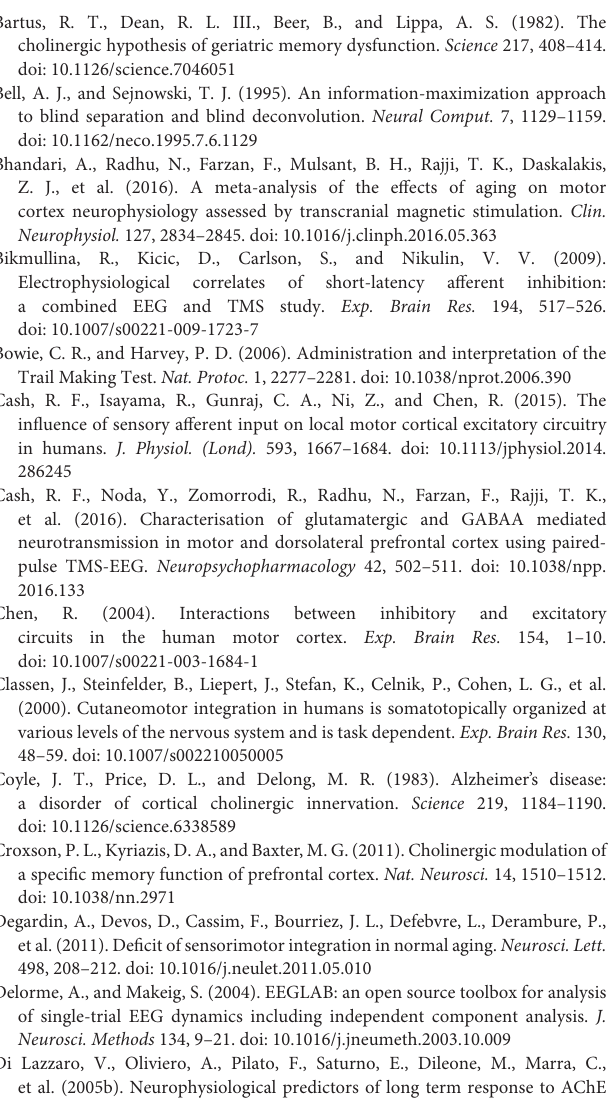
condition (ISI N20 + 4). Significant TEP modulations by SAI paradigm within a younger group are shown in asterisks. Supplementary Figure 3 | (A) M1–SAI in older participants. TEP trace in red represents TS condition while TEP trace (SAI’) in blue represents SAI condition (ISI N20 + 2) without SSEP subtraction. A light blue trace represents SSEP. (B) DLPFC–SAI in older participants. TEP trace in red represents TS condition while TEP trace (SAI’) in blue represents SAI condition (ISI N20 + 4) without SSEP subtraction. A light blue trace represents SSEP. Supplementary Figure 4 | (A) TEP amplitude differences of M1–SAI between younger and older participants. Compared to younger participants, older participants showed a significant increase of N100 TEP amplitude modulation (SAI – TS) with SAI paradigm (t 22 = − 2.931, p = 0.008). However, there was no significant difference on N45 TEP amplitude change between the two groups. (B) TEP amplitude differences of DLPFC–SAI between younger and older participants. Compared to younger participants, older participants showed a significant increase of N100 TEP amplitude modulation (SAI – TS) with SAI